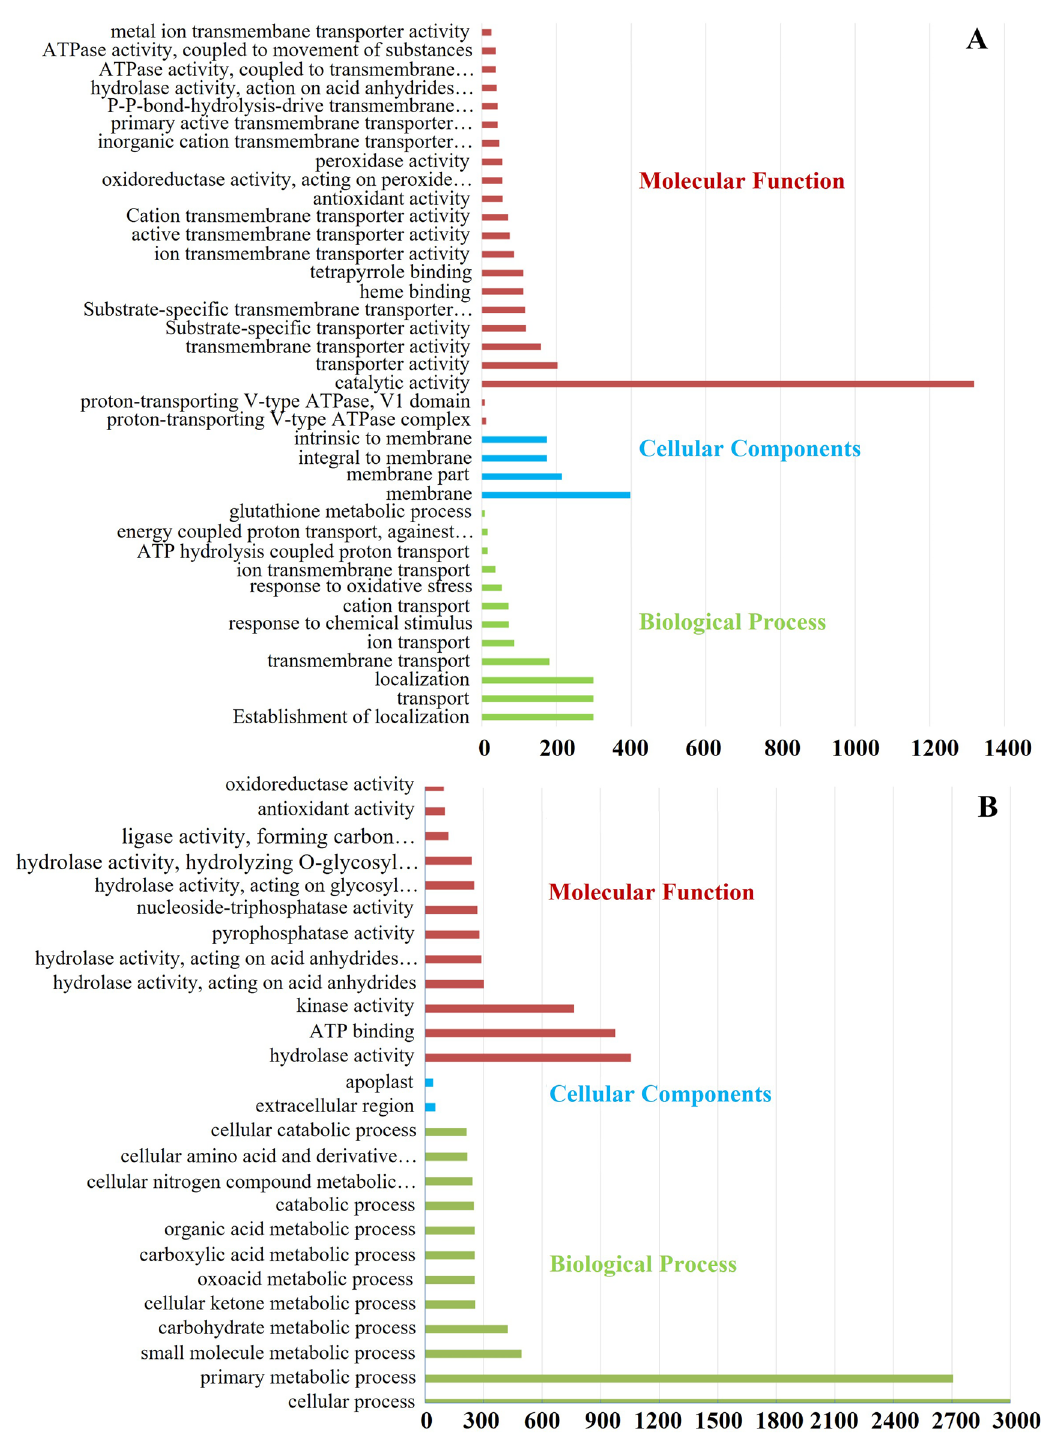
Figure 4. Gene Ontology (GO) enrichment terms of DEGs. Bars represent the number of genes enriched in LCR versus ConR ( A ), and the number of genes enriched in LCS versus LCS ( B ). GO annotation was performed as described in the “Materials and methods”